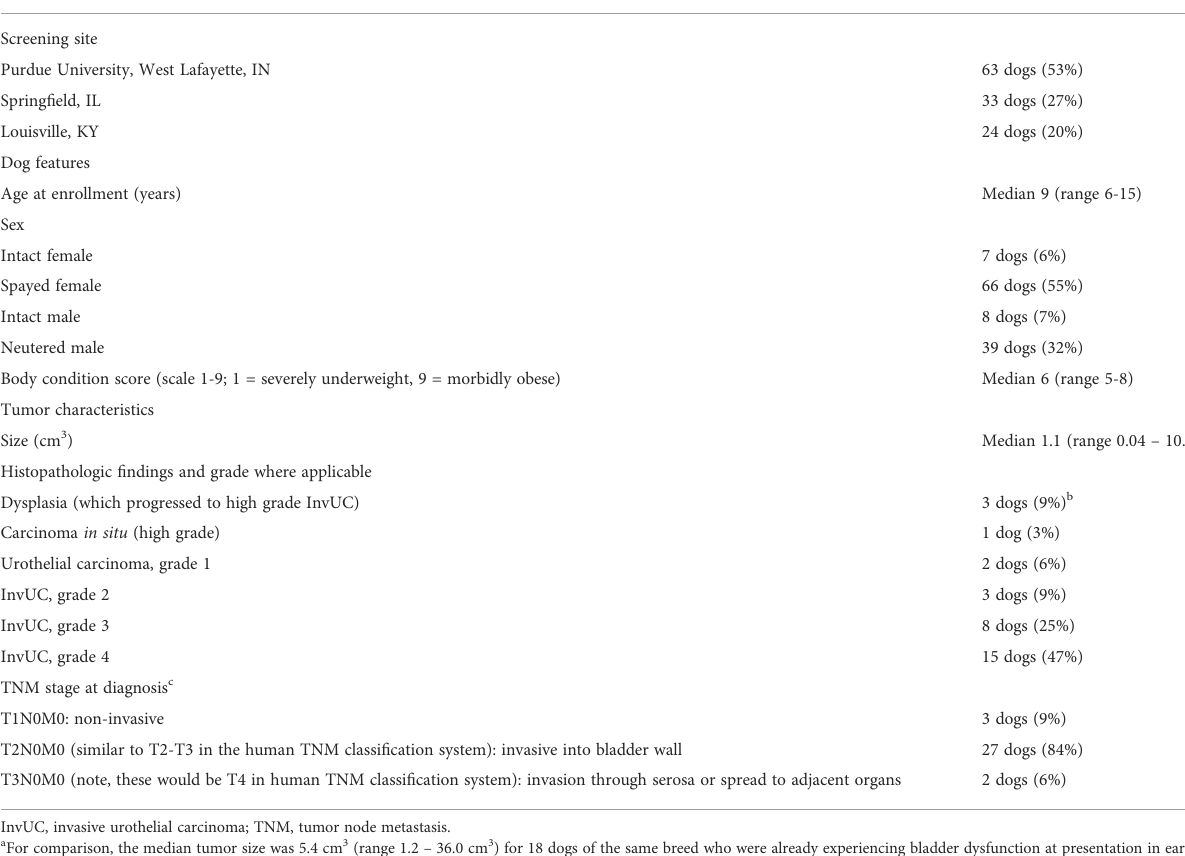
TABLE 1 Screening site, dog features, and tumor characteristics for the dogs participating in the 3-year bladder cancer screening and early intervention study.